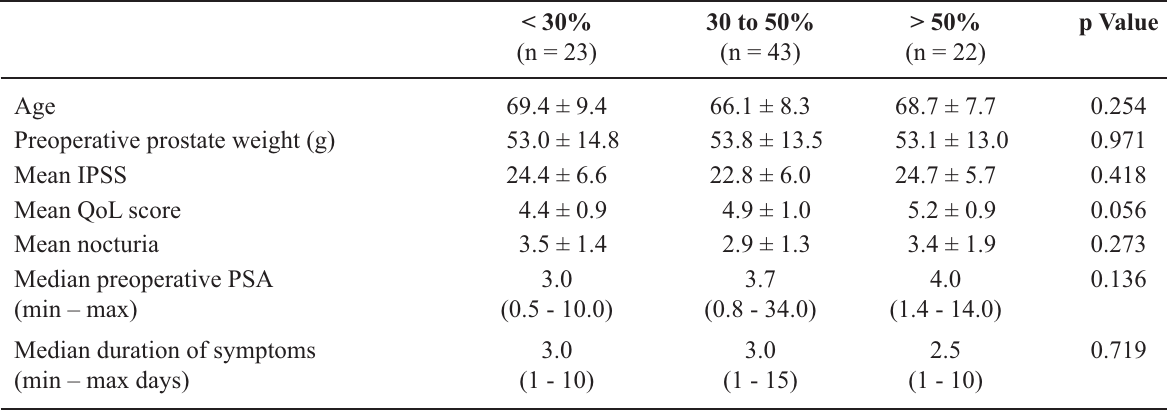
Table 1 – Baseline characteristics of patients according to the percent of resected